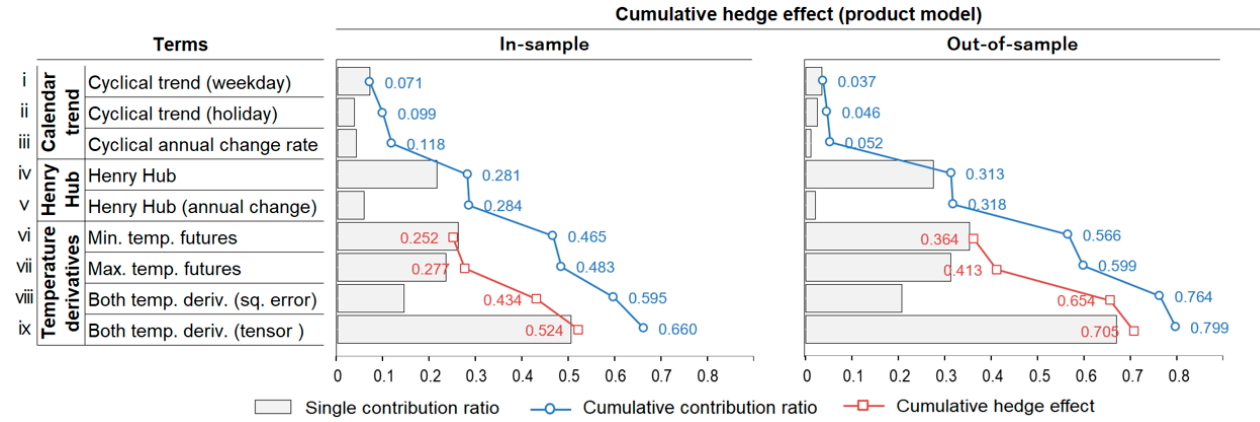
Figure 9. Contribution ratio and hedge effect of product model.